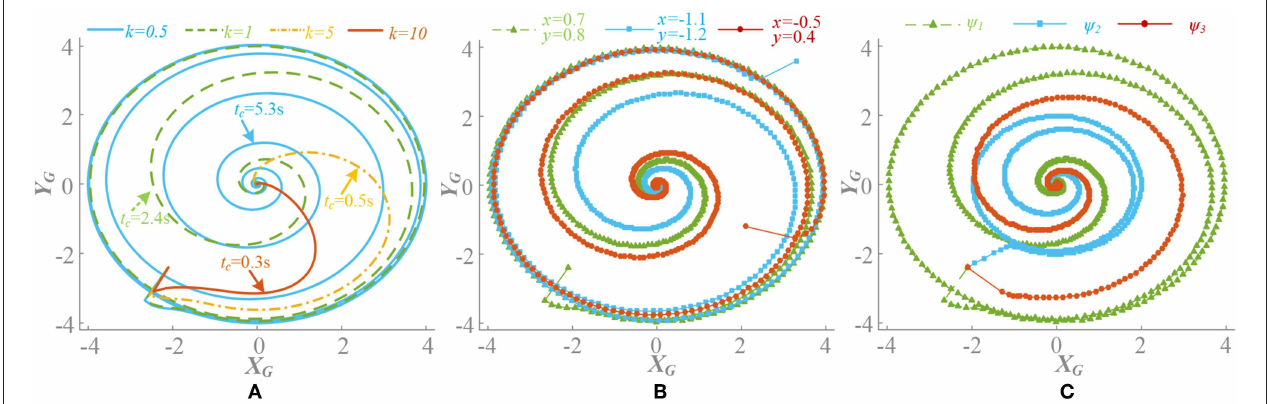
FIGURE 3 | Convergence process of G { G ( ¯ υ 0 ), k ( t ) } with influence of different parameter ( ρ = 0.5). Signal of limb 1 is selected. (A) Different value of k (t), phase factors ψ i = Φ i /2 π , ψ = [0, 0.5, 0.5, 0, 0, 0.5], initial point is (0.7, 0.8). Different k (t) leads a different convergence rate. (B) Different initial points ( x 0 , y 0 ), k (t) = 1, ψ = [0, 0.5, 0.5, 0, 0, 0.5]. Initial point has little influence on convergence rate, but is important to synchronization process. (C) Different phase factors ψ 1 = [0, 0.5, 0.5, 0, 0, 0.5], ψ 2 = [0, 0.5, 0, 0.5, 0, 0.5], ψ 3 = [0.2, 0.4, 0.6, 0.1, 0.9, 0.7]. k (t) = 1, initial point is (0.7, 0.8). A different phase factor means a different synchronization process.